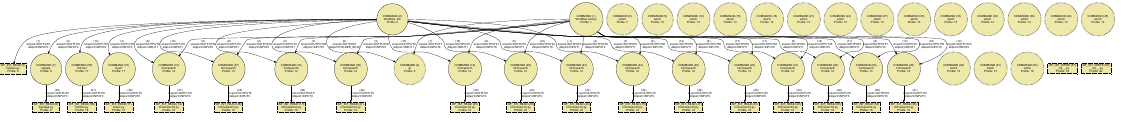
Figure 3: Inmembrane dataflow graph.